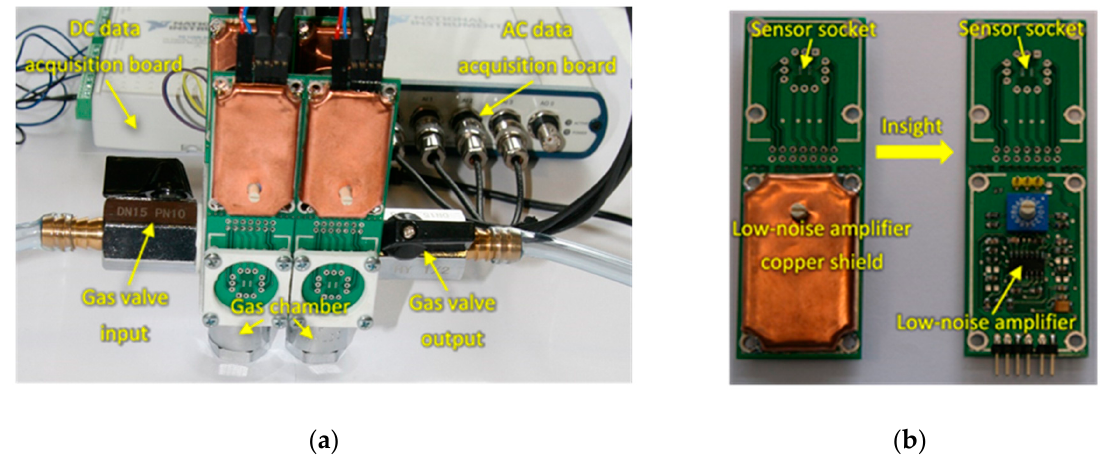
Figure 1. ( a ) Measurement setup; ( b ) Insight of the AC fluctuations measurement board.